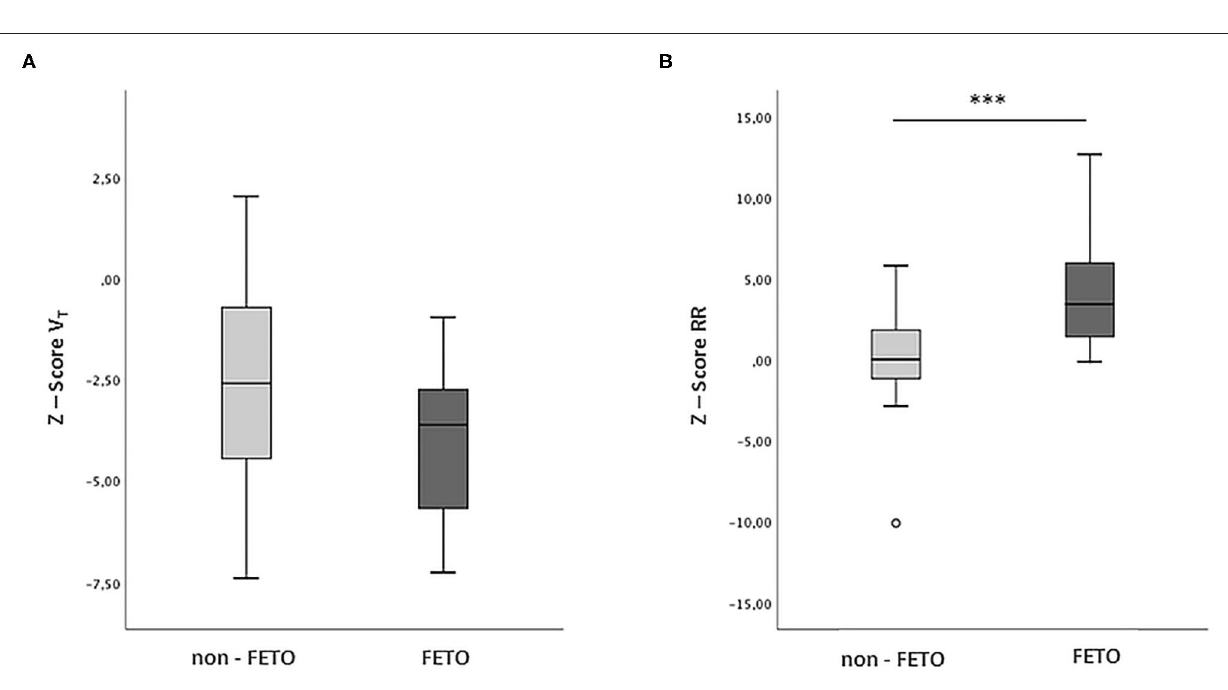
included infants born at term with adequate gestational age, predominantly affected by mild forms of CDH. In particular, initial hernia severity was drastically unbalanced between FETO and non-FETO groups, since the first was constituted by severe forms, while all patients presenting mild forms were included in the latter. However, O/E LHR% before birth was even better in the FETO group, suggesting that only those with optimal response to prenatal treatment were included. Furthermore, in